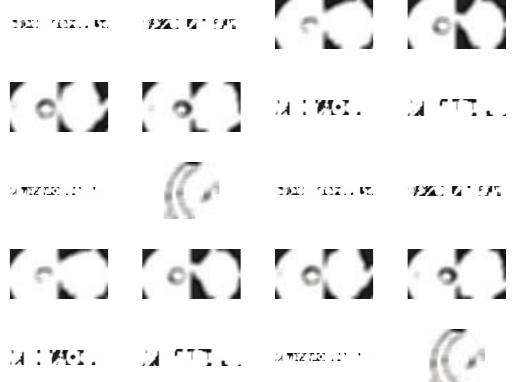
Figure 2: Gabor Kernal Filer Output.